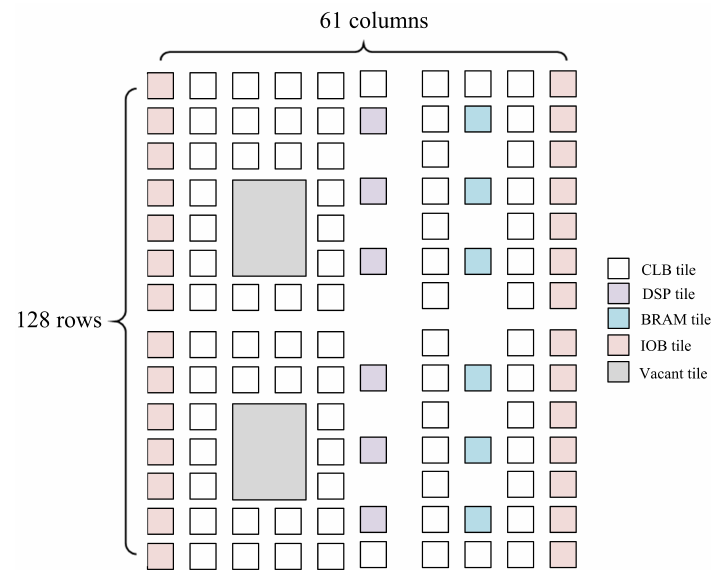
Figure 15. Architecture of the